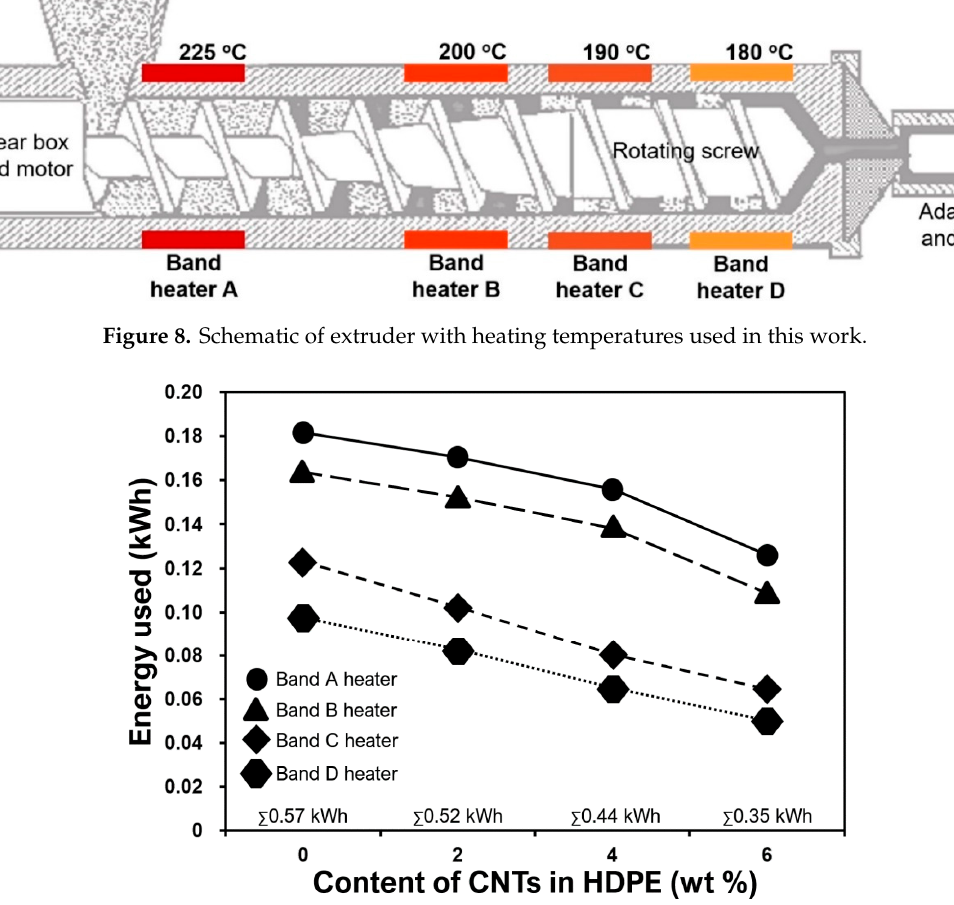
Figure 9. Energy used by respective band heaters for a complete 10 min extrusion cycle. The total energy, the sum ( ∑ ) of energy data points for every concentration, is on the horizontal axis line.